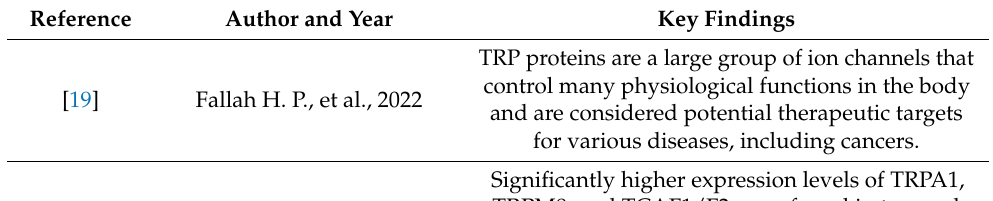
Table 1. Recent studies have shown a role for TRP channels in